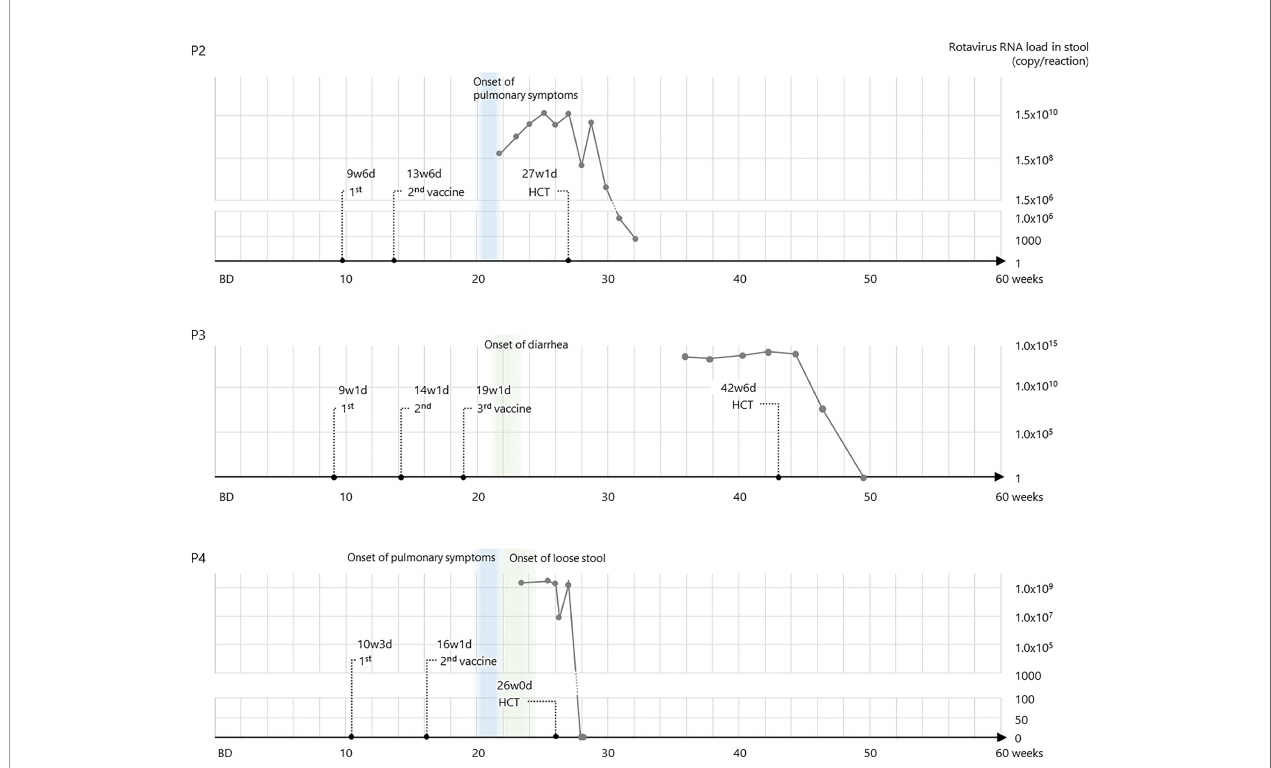
FIGURE 2 | RV5 genotype G1 RNA loads in the stool samples of patients 2, 3, and